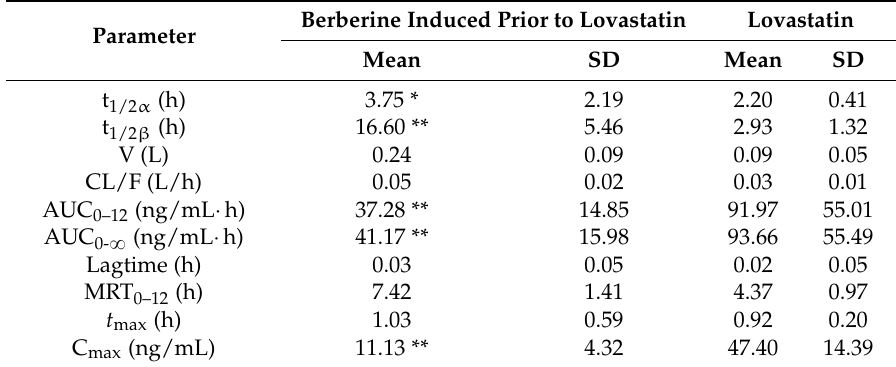
Figure 3. The drug plasma concentration (ng·mL − 1 )-time (hour) profile of lovastatin acid obtained from berberine induced lovastatin and lovastatin, respectively. Table 3. The main pharmacokinetics parameter between berberine induced prior to dosing with lovastatin and a single dose of lovastatin.